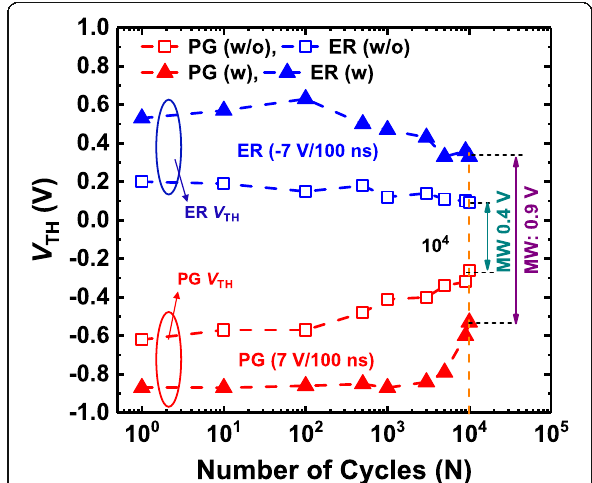
Fig. 7 Evolution of V TH with P/E